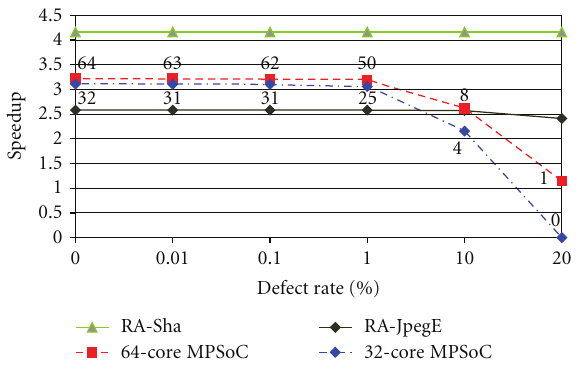
Figure 20: Graceful degradation of 32-core and 64-core MPSoC— under di ff erent defect rates and comparing with FAT-array graceful degradation when executing sha and jpegE applications.